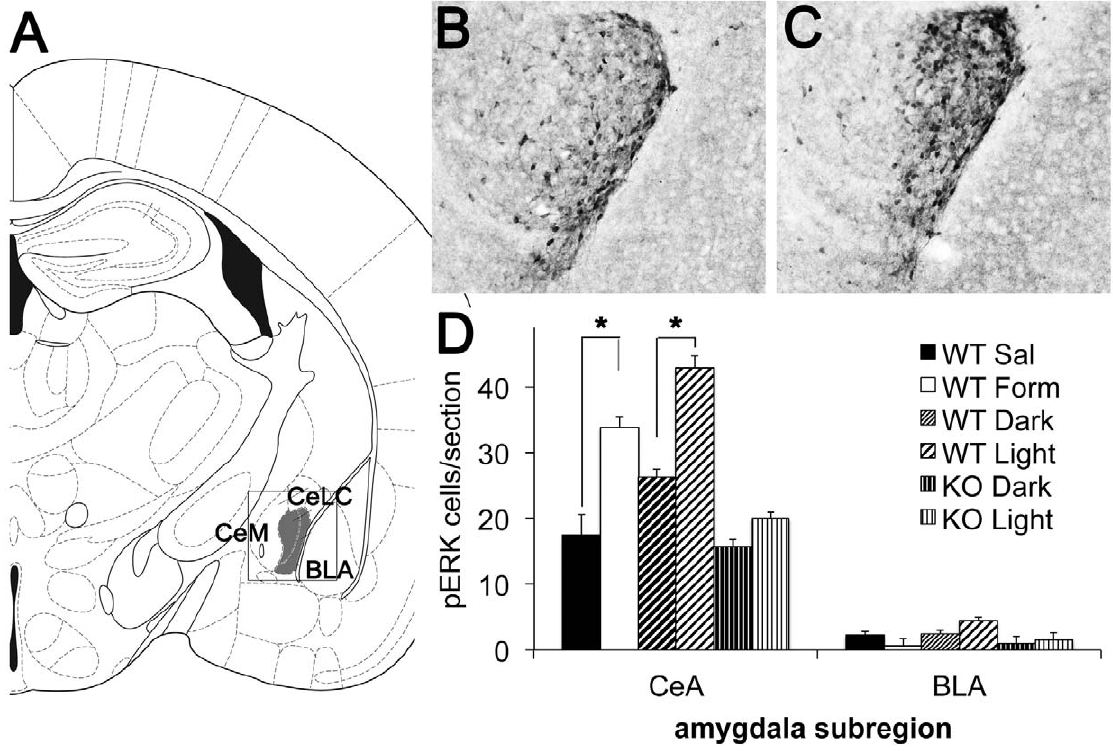
Figure 3. Light activates neurons in central amygdala. (A) Line drawing indicating the region of interest within the basolateral (BLA), the medial (CeM) and lateral and capsular portions of the central (CeLC) amygdala. The boxed outline indicates the region of the amygdala represented in the micrographs to the right. (B) Example of pERK staining in a sham-treated P8 mouse pup that remained in the dark (WT Dark). (C) Example of pERK staining in P8 mouse pup exposed to light for 30 min (WT Light). (D) Quantification of the number of pERK-expressing neurons in CeLC and BLA areas. There were many fewer pERK-labeled cells within the CeM and BLA, and the BLA was counted as an out of region control. In WT pups, light produced a 1.6-fold increase in the number of pERK-expressing neurons (WT Dark pups n=8 and WT Light pups n=9). Supraorbital formalin injections produced a 2-fold increase in Fos staining compared to saline injections. (n=4, both saline and formalin groups). Light did not induce pERK cells in KO mice (KO Dark n=5, KO Light n=9). Data are presented as means of the average number of pERK staining neurons in each animal 6 SEM. Asterisks (*) indicate p , 0.01.